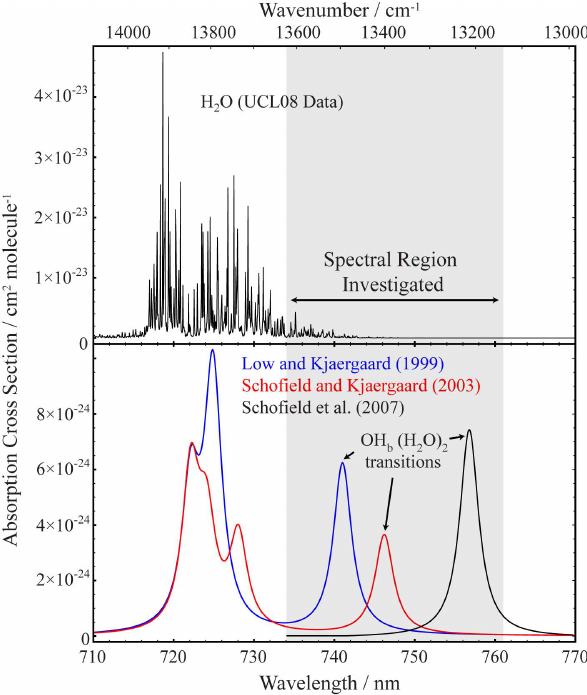
Fig. 2. Water dimer absorption bands for the stretching overtone (and nearby dimer transitions) predicted by the- oretical studies (lower panel). The dimer bands are shown for an assumed Lorentzian line profile of 25cm − 1 HWHM. The upper panel shows high resolution absorption cross sections of the water monomer calculated with the UCL08 line list (air broadened lines). The shaded region indicates the wavelength range of the BBCRDS